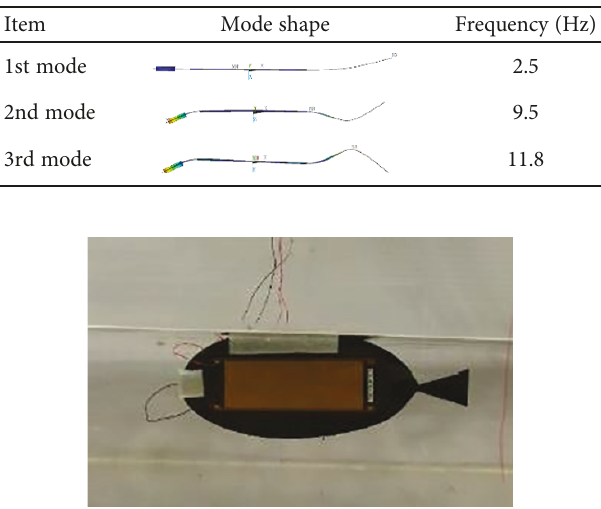
Figure 7: Prototype of the new soft robotic fi sh.